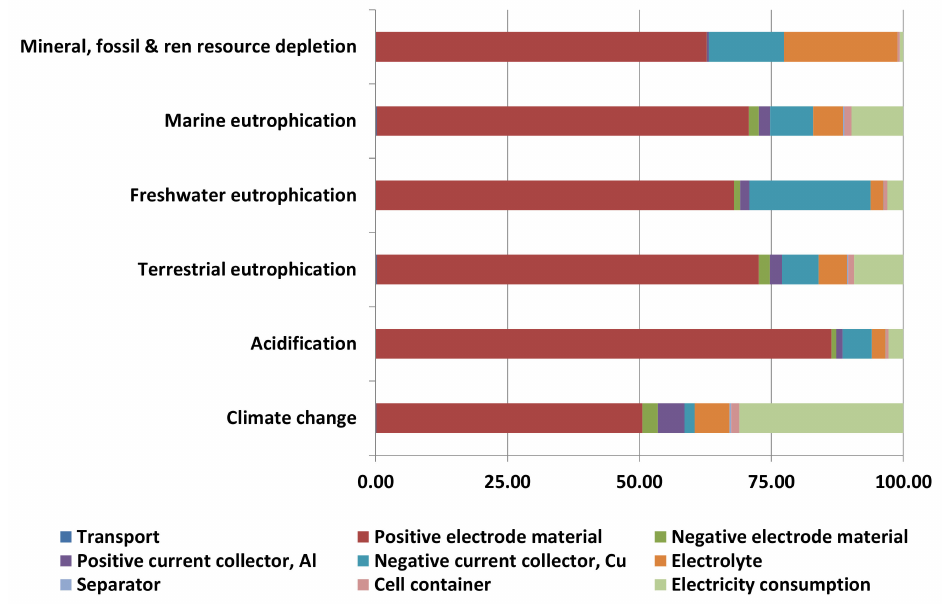
Figure 7. Life cycle impacts of NMC 622 battery cell production, broken down into key processes.